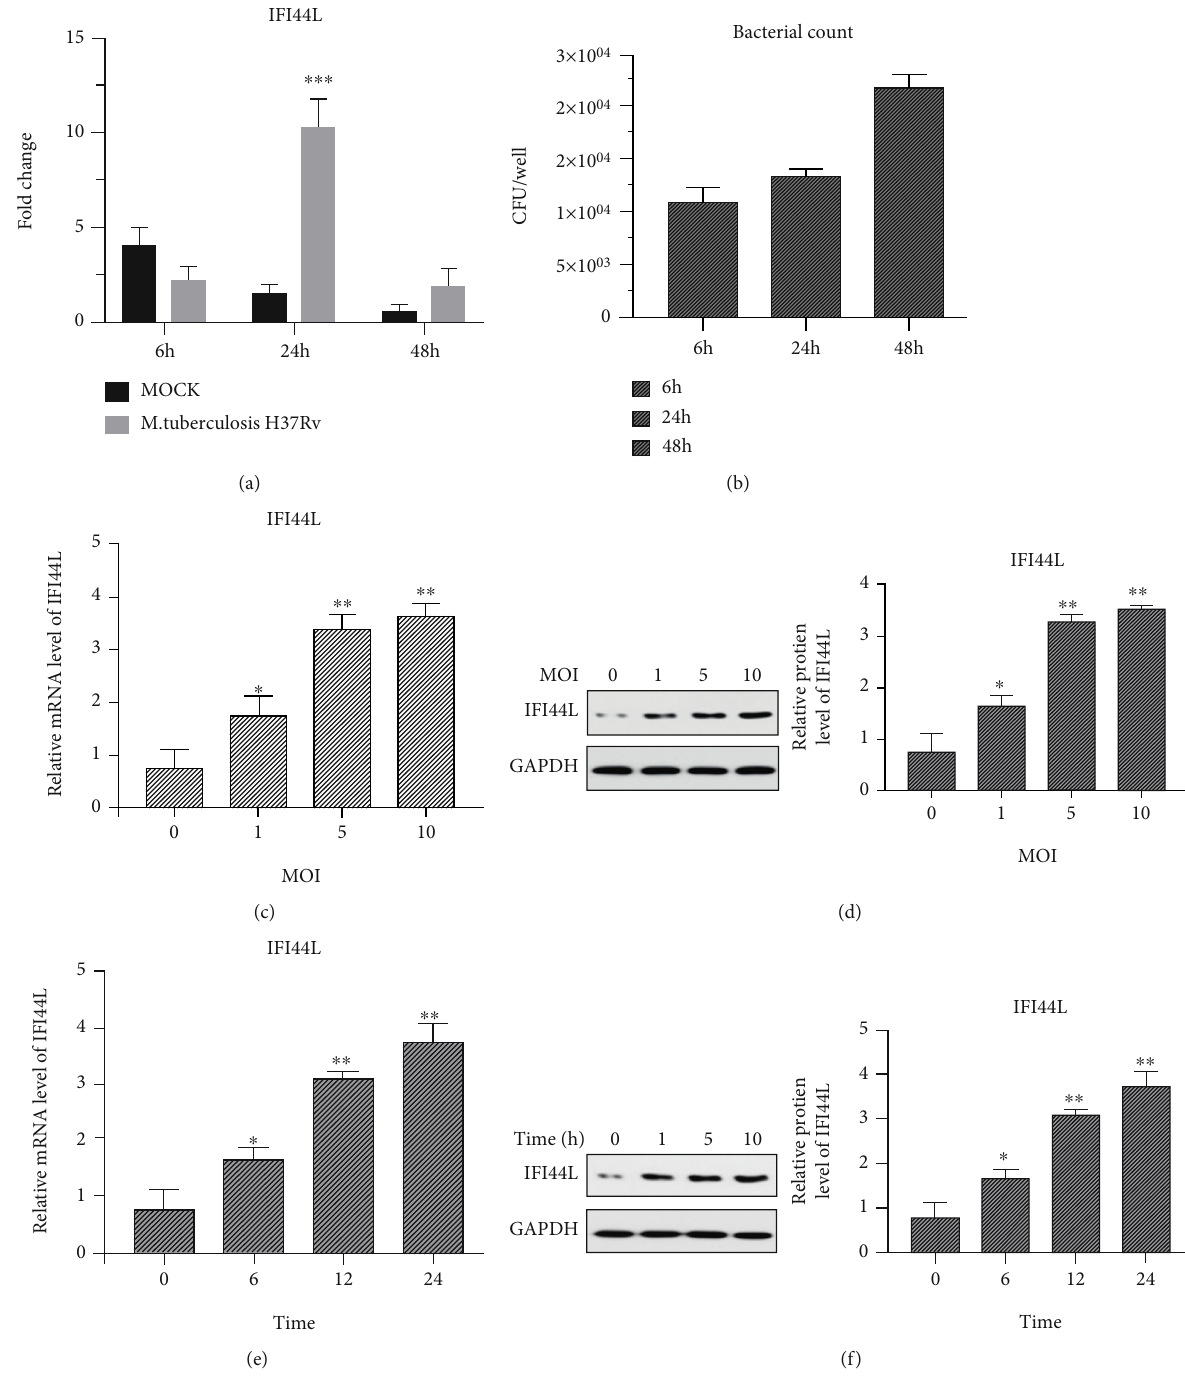
Figure 2: IFI44L induced by M. tuberculosis H37Rv-infected macrophages. (a) IFI44L was signi fi cantly upregulated at 24 h in M. tuberculosis H37Rv-infected macrophage group. (b) Intracellular M. tuberculosis H37Rv bacteria were collected in 6, 24, and 48 h for culture in L-J medium. CFU is the number of colony-forming units. (c, d) THP-1 cells infected with M. tuberculosis H37Rv at MOIs of 0, 1, 5, or 10 for 24h. IFI44L expression measured by qPCR and Western blot analysis. (e, f) THP-1 cells infected with M. tuberculosis H37Rv at an MOI of 5 for 0, 6, 12, and 24 h and IFI44L level detected by qPCR and Western blot analysis. Values are presented as levels relative to β -actin and GAPDH. ∗ P < 0 : 05 , ∗∗ P < 0 : 01 , and ∗∗∗ P < 0 : 001